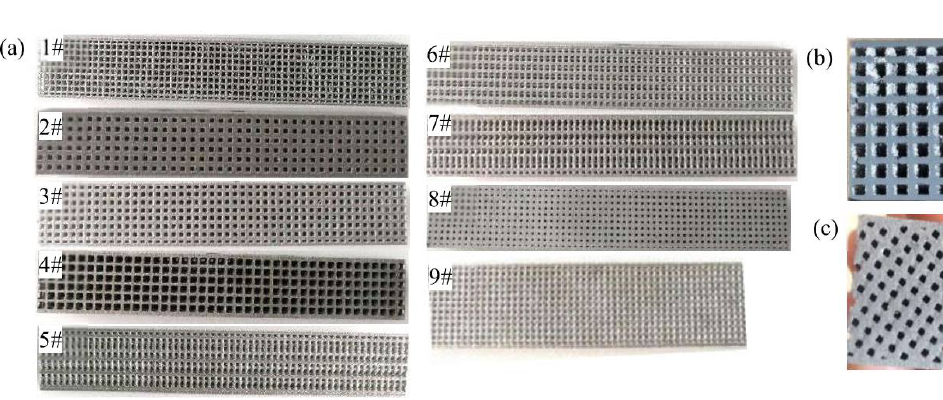
Figure 2. Samples manufactured by SLM: ( a ) samples with different geometric parameters, cross sections of ( b ) 2#, and ( c ) 7# sample.